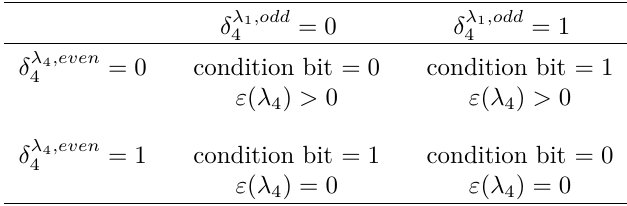
Table 18: Four Cases for the Possible Values of δ λ 1 ,odd